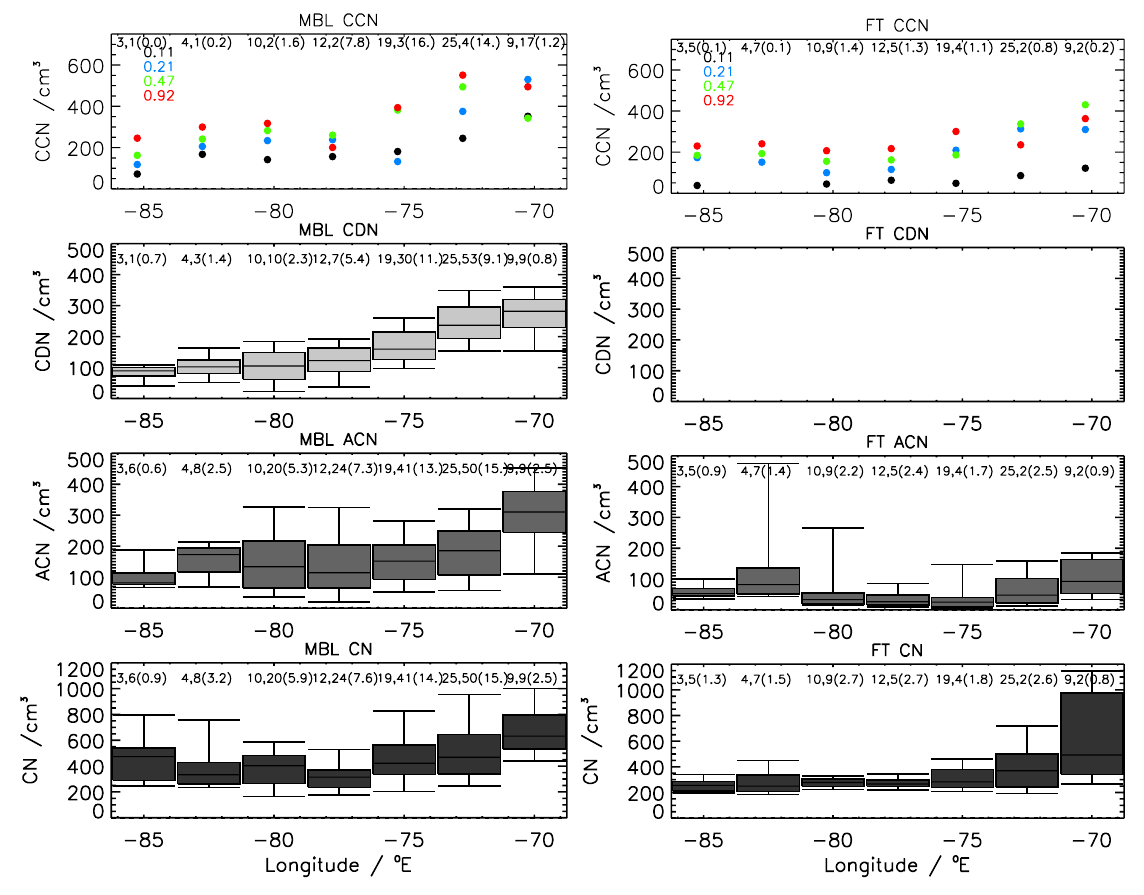
Fig. 11. Aerosol concentration and cloud physics measurement statistics averaged into 2.5-degree longitude zones below 1200m altitude (left panels) and between 1700–3200m altitude (right panels). For each vertical domain, cloud condensation nucleus concentration (CCN), cloud droplet number (CDN), accumulation mode aerosol concentration (ACN) and total condensation nuclei greater than 10nm particle diameter (CN) are plotted as titled. With the exception of CCN data, for each longitude zone, thick centre lines indicates the sample median, dashed lines indicate the mean, boxes indicate upper and lower quartiles with upper and lower decile whiskers. Only median data are presented for CCN, colour-coded to supersaturation as labeled in the figure. Plotted above each longitude zone and for each panel, numbers before the comma indicate number of flights contributing to each statistic, followed by the number of straight and level runs, with the total sampling time in decimal hours in